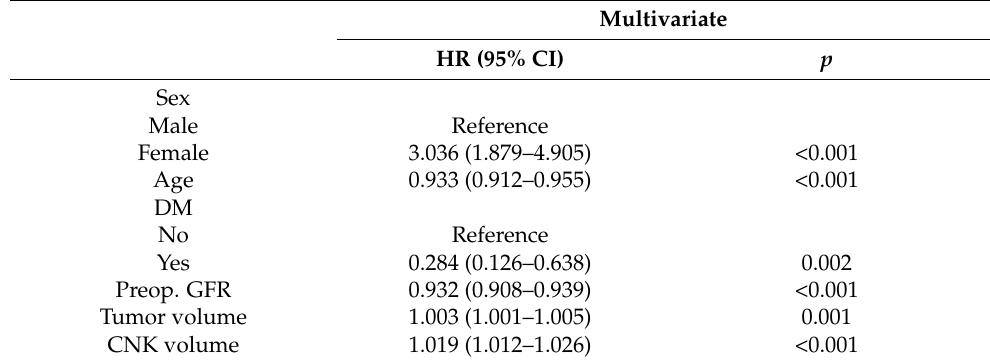
Table 4. Multivariate logistic regression analysis of factors associated with compensation from preop- erative period to postoperative 5 years (process 1 + 2) in patients treated with radical nephrectomy for